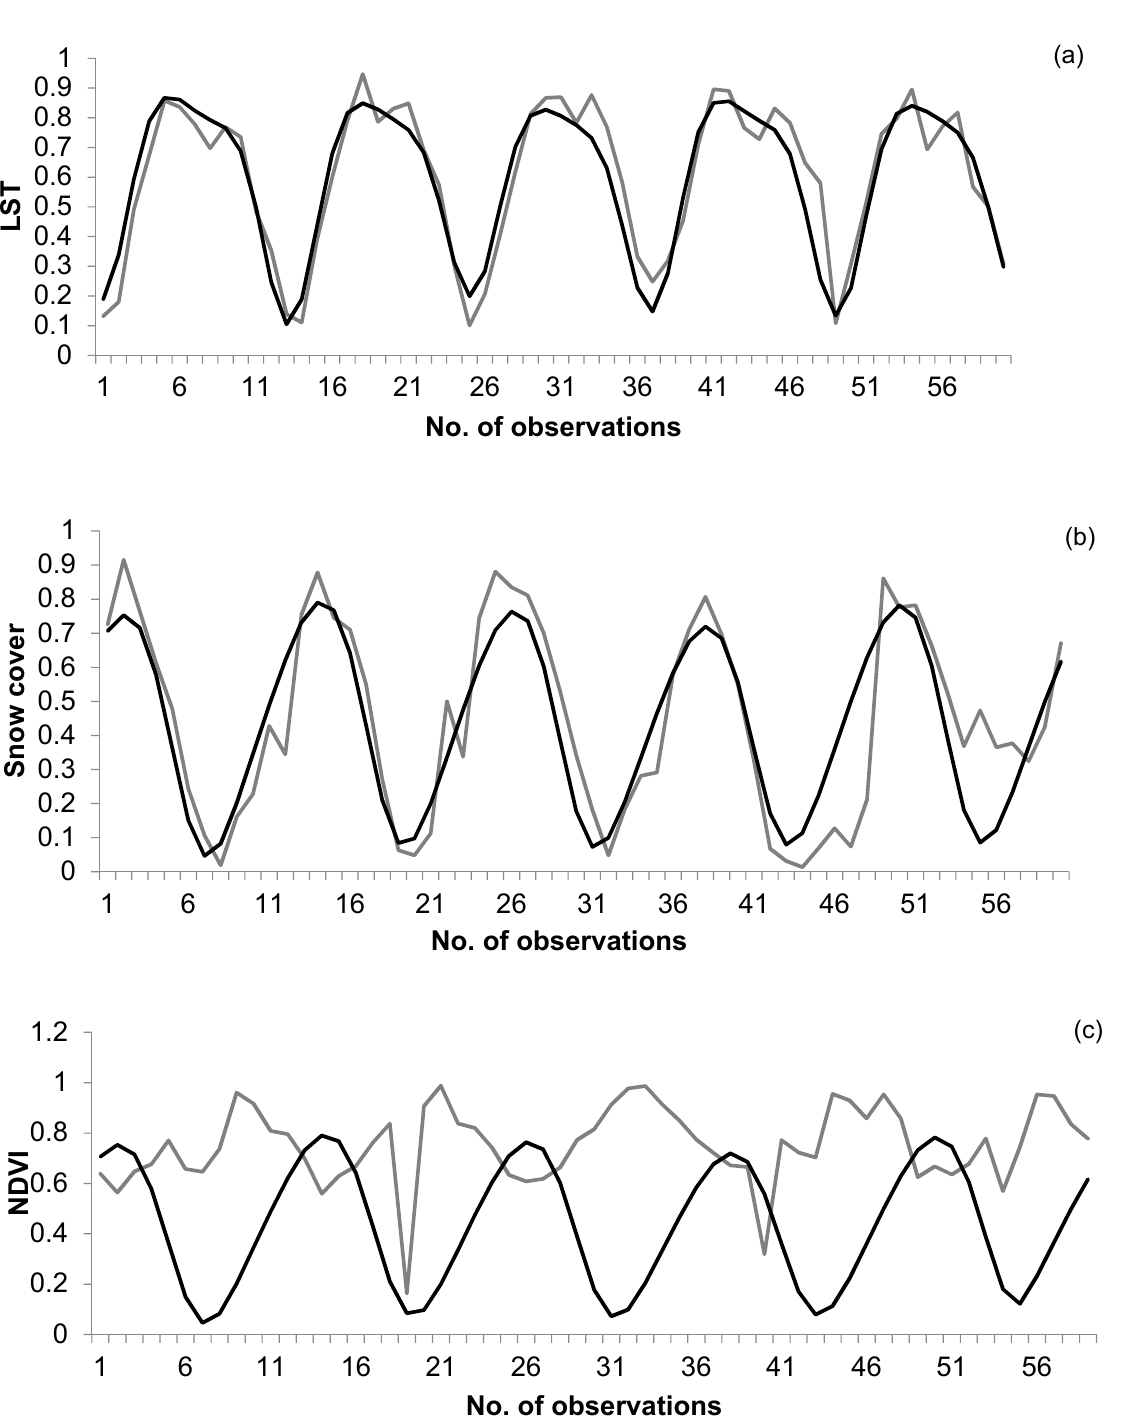
Figure 11. ( a ) Linear curve for the forecasted values of temperature using LSTM networks (black curve) and average values of temperature obtained using MODIS grids (grey curve) for each month for the years 2012–2017 for entire Uttarakhand. ( b ) Linear curve for the forecasted values of snow covers using LSTM networks (black curve) and average values of snow covers obtained using MODIS grids (grey curve) for each month for the years 2012–2017 for entire Uttarakhand. ( c ) Linear curve for the forecasted values of NDVI using LSTM networks (black curve) and average values of NDVI obtained using MODIS grids (grey curve) for each month for the years 2012–2017 for entire Uttarakhand. Forecasted values of the climate parameters obtained through LSTM networks and actual values obtained through MODIS grids were compared using regression and corre- lation. LSTM networks can be considered appropriate for forecasting of temperature (R-